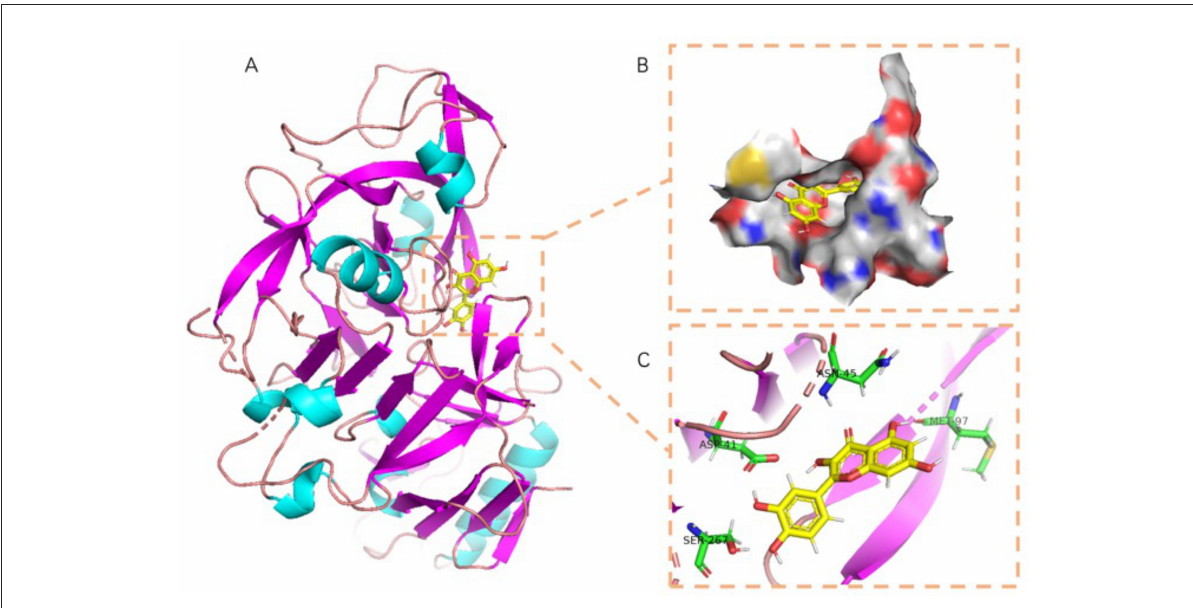
FIGURE7 The binding mode of 7S with quercetin: (A) The 3D structure of complex. (B) The surface of active site. (C) The detail binding mode of complex. The backbone of protein and quercetin compound were colored at the